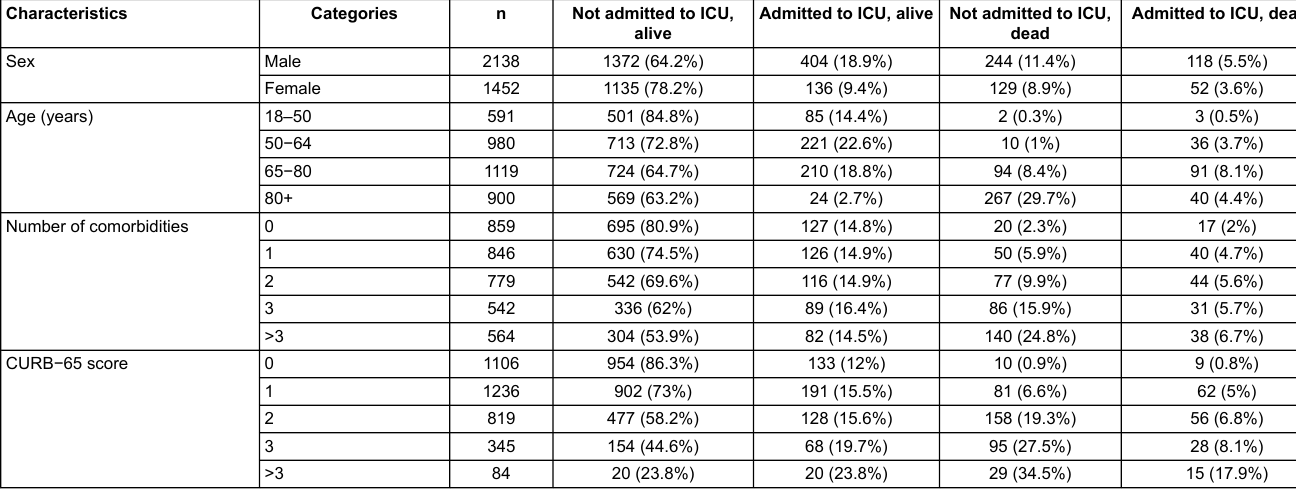
Characteristics